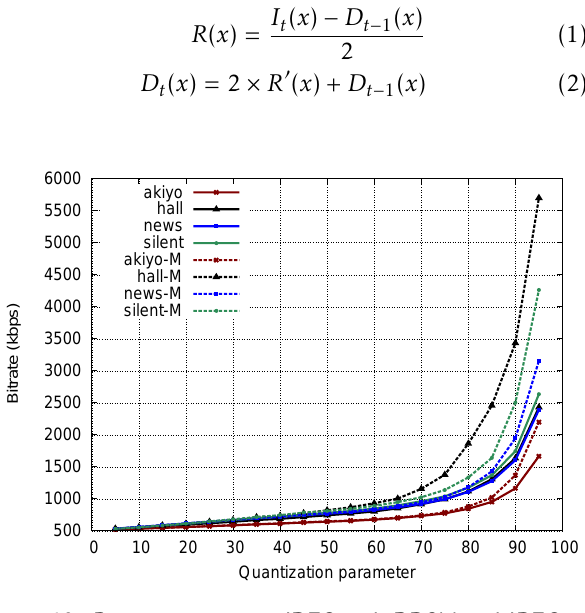
Figure 10. Bitrate comparison: JPEG with DPCM and JPEG in simulated